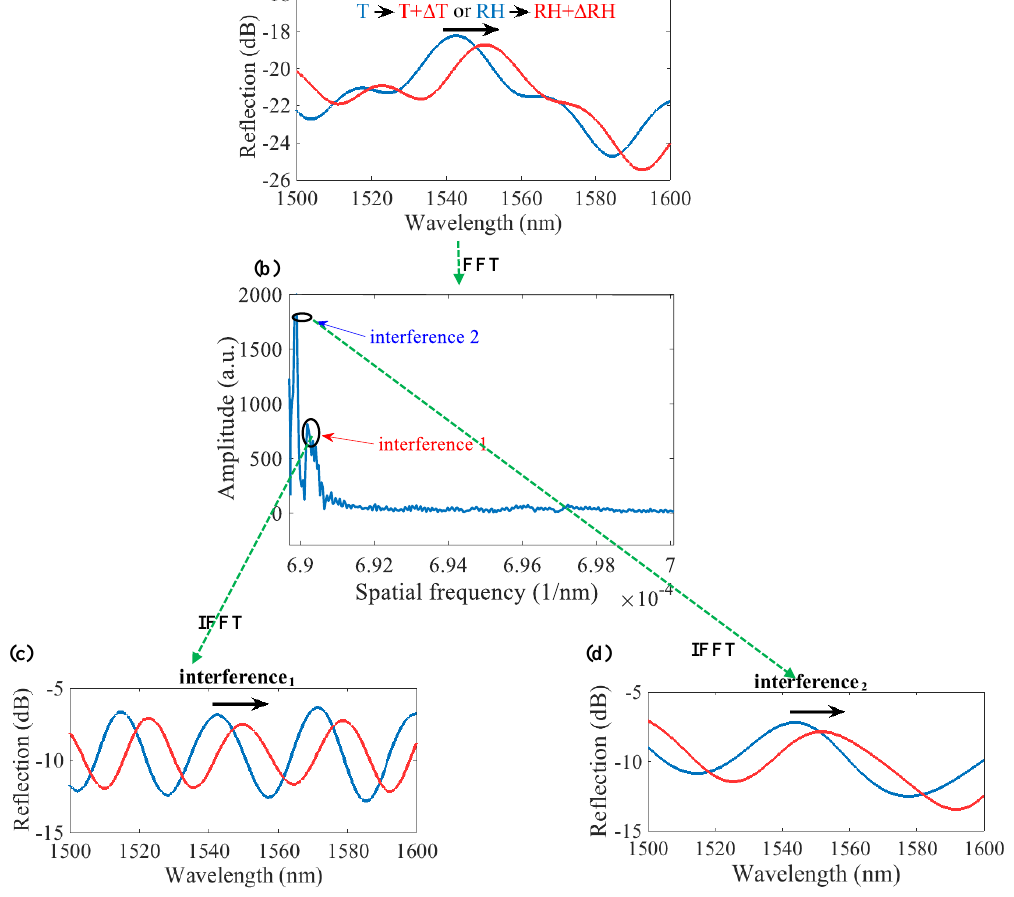
Figure 3. ( a ) Optical response of superimposed interference measured by the OSA; ( b ) superimposed spectra processed by FFT; separated optical spectra of ( c ) interference 1 and ( d ) interference 2 , respectively.